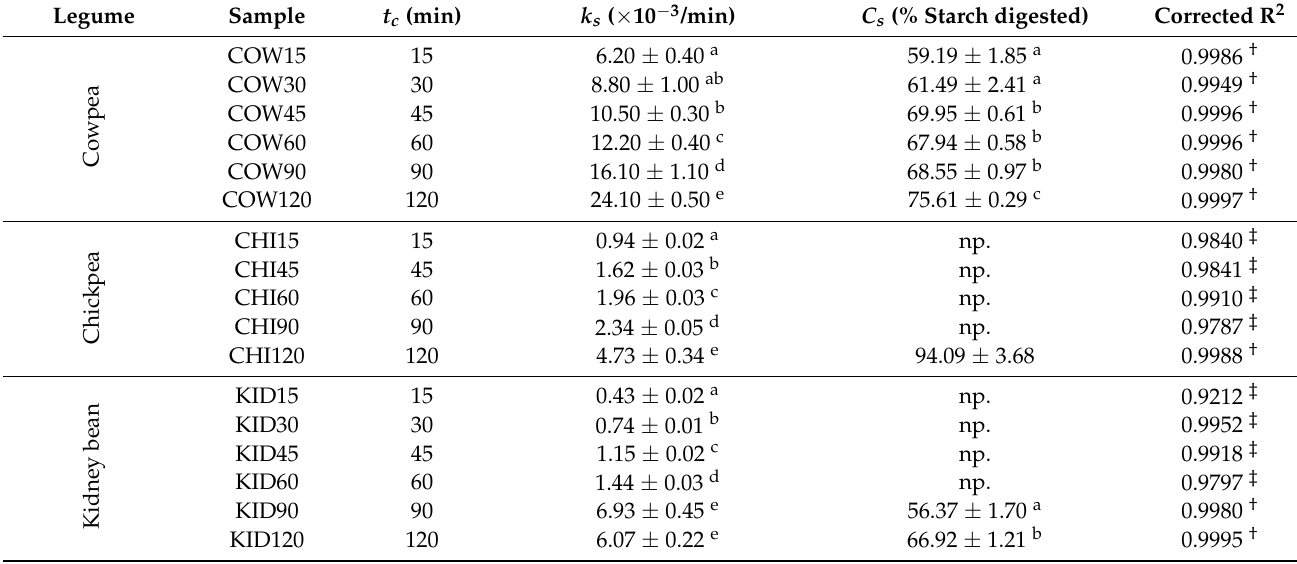
Table 3. Estimated starch digestibility kinetic parameters for different boiled cowpeas, chickpeas and kidney beans during in vitro small intestinal digestion.